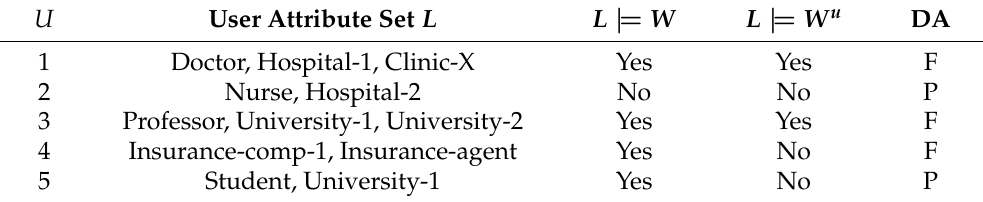
Table 3. Users satisfying policy and access type